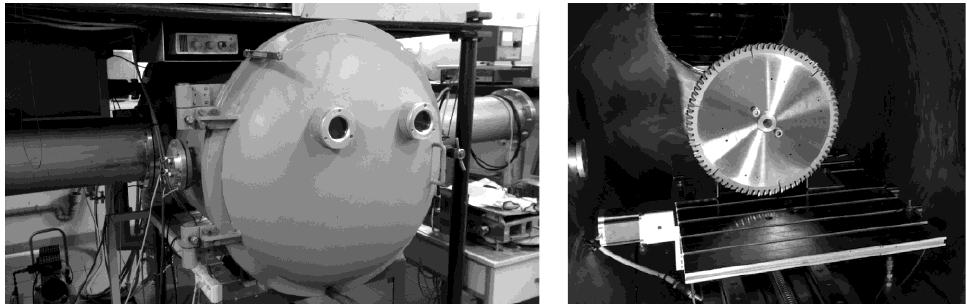
Figure 2. Main view of the ion implanter ( left ) and view of the circular saw blade ’ s package inside the implanter vacuum chamber ( right ).